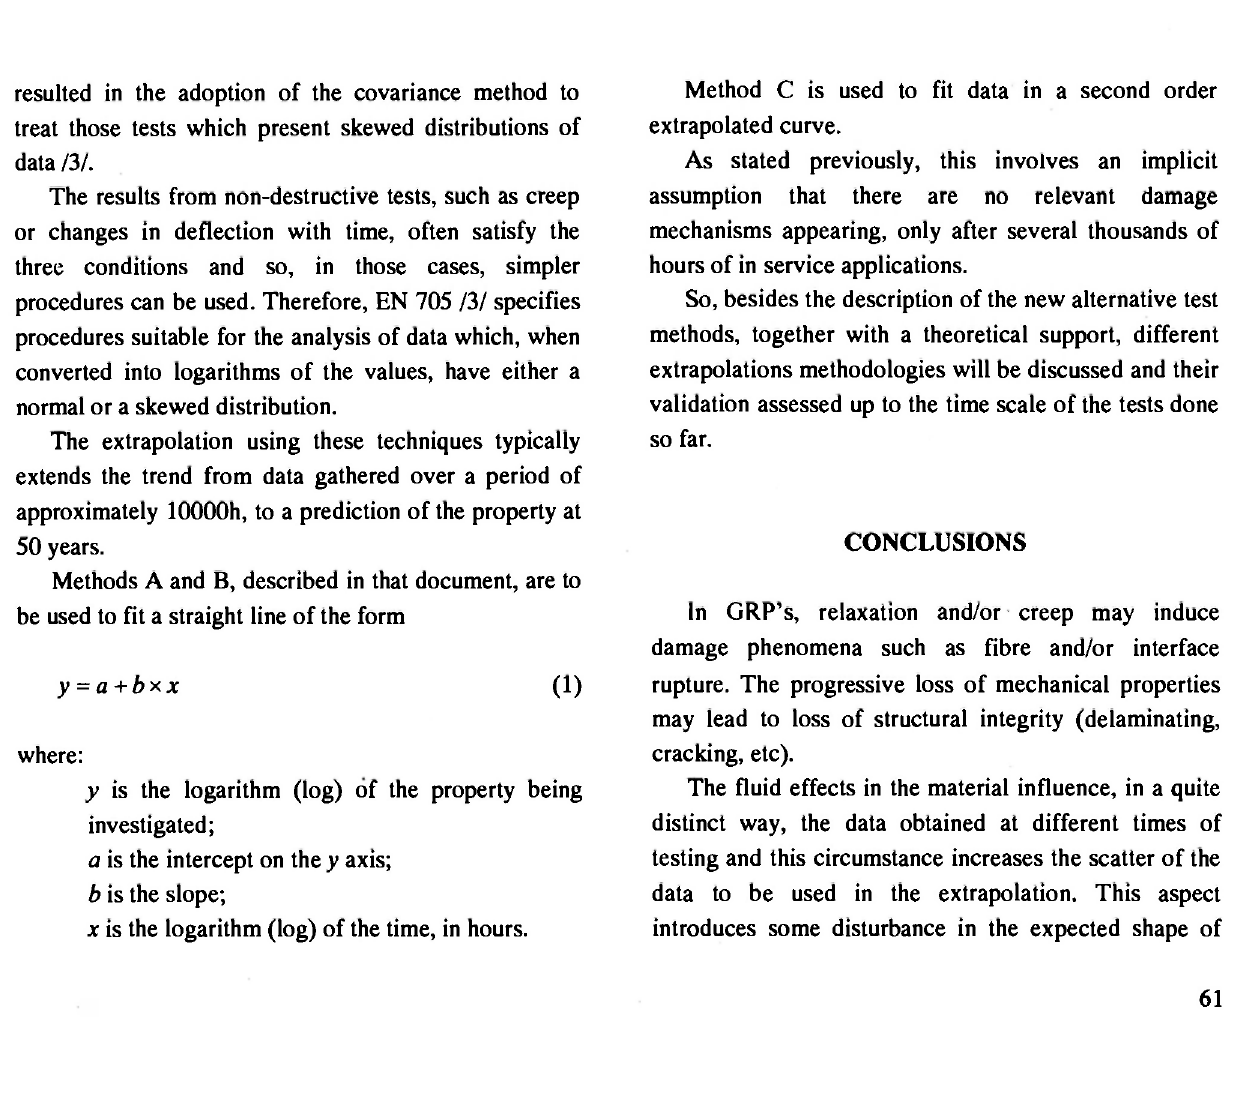
Fig. 9: Scattering of initial relative ring stiffness of specimens of same type and manufacturer